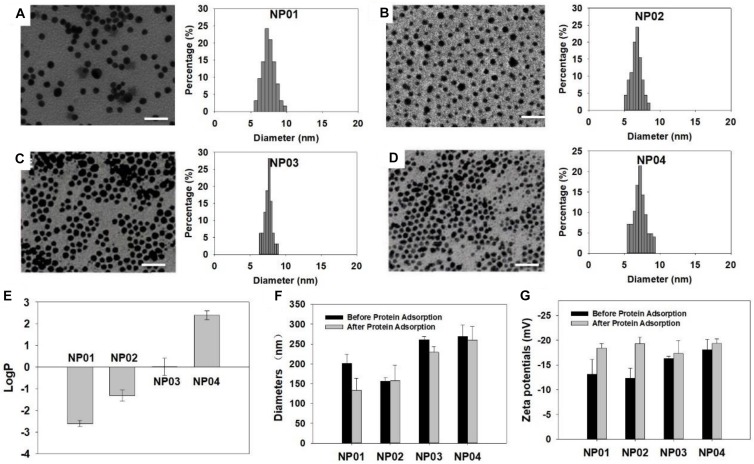
Characterization of NPs. (A–D) TEM images and size distribution of NPs. (A) NP01, (B) NP02, (C) NP03, (D) NP04. Scale bar: 25 nm. (E) LogP values of NPs. (F) Hydrodynamic diameters and (G) zeta potentials of NPs before and after protein adsorption.